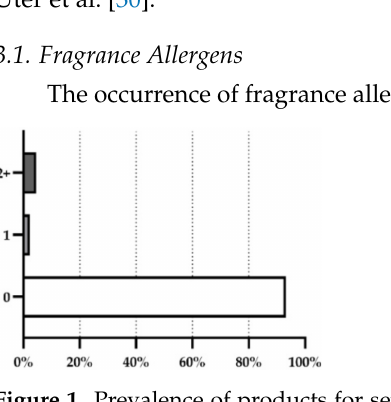
Figure 1. Prevalence of products for sensitive skin that contained no fragrance allergens (0), one fragrance allergen (1), and combination of fragrance allergens